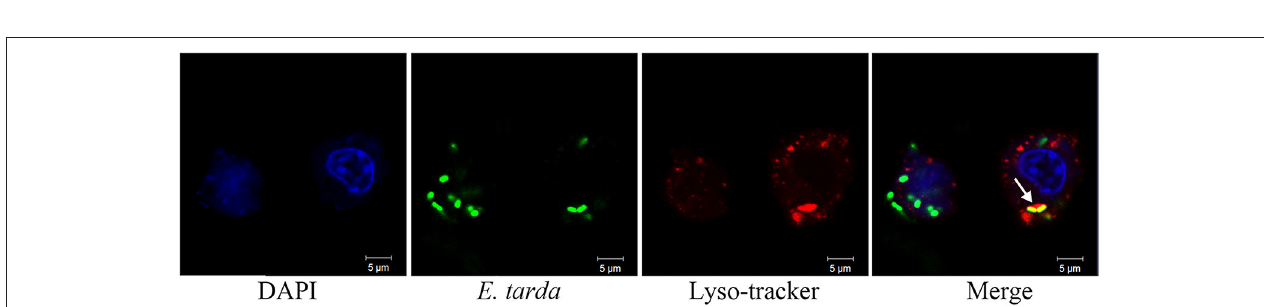
FIGURE 4 | Co-localization of Edwardsiella tarda with early and late endosome markers. RAW264.7 cells infected with E. tarda TX1G for 1 h (A) or 1.5 h (B,C) were treated with Alexa Fluor594-labeled antibody detecting Rab5 (A) , Lamp1 (B) , or cathepsin D (C) . The cells were stained with DAPI and observed with a confocal microscope. White arrows indicate co-localization of bacteria and the respective marker.